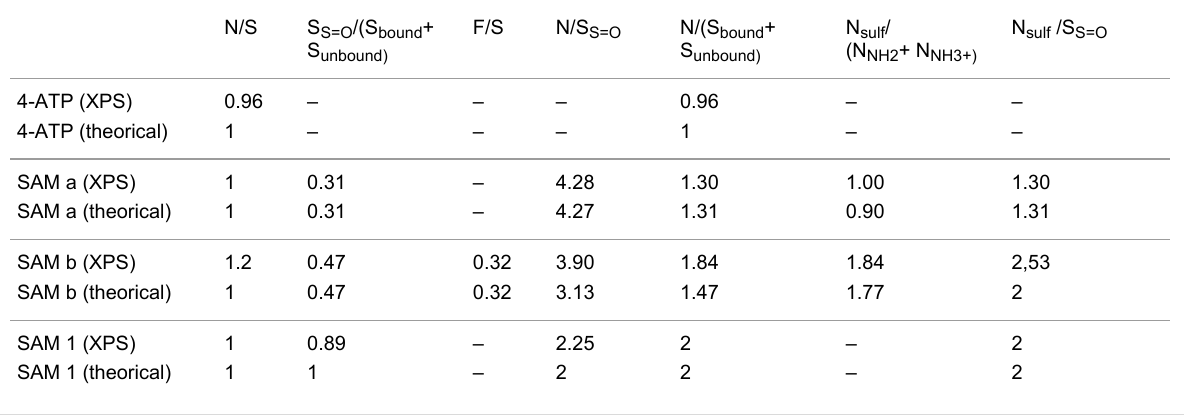
Table 2: Experimental (XPS) and theoretical characteristic ratios of the 4-ATP SAM, the 4-ATP SAM after reaction with 4-FC 6 H 4 SO 2 NHOSO 2 -4- FC 6 H 4 (SAM b) or TsNHOTs (SAM a) and SAM 1. The theoretical ratios were calculated with a conversion rate of 47 and 31% for SAM b and SAM a, respectively.